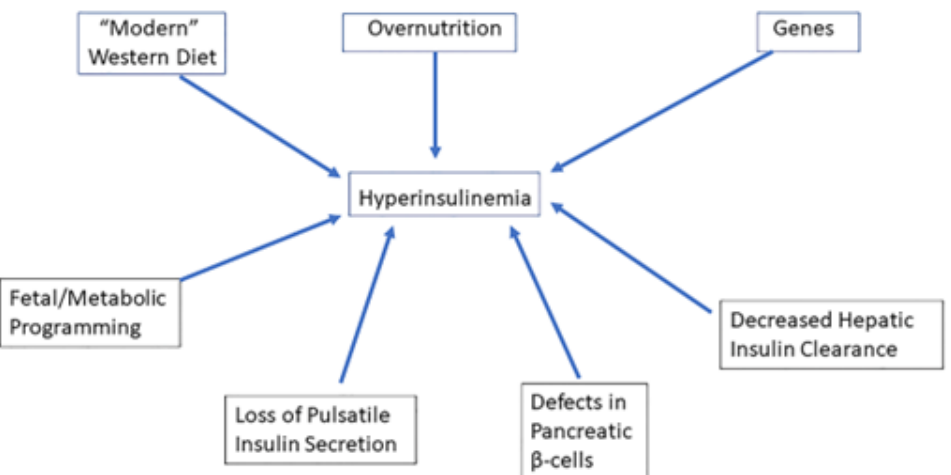
Figure 2. Factors involved in primary hyperinsulinemia. Consumption of the “modern” Western diet, over-nutrition, genes, defects in pancreatic β -cells, decreased hepatic insulin clearance, loss of pulsatile insulin secretion, and fetal/metabolic programming may increase insulin secretion, thereby causing chronic hyperinsulinemia and hyperinsulinemia-induced insulin resistance. In the alternate concept, hyperinsulinemia precedes impaired insulin secretory function during the conversion from normoglycemia to (pre) diabetes onset: hyperinsulinemia-induced insulin resistance is considered a physiological protective defense mechanism of the body that tries to prevent hypoglycemia and to protect critical tissues from metabolic stress and nutrient-induced injury